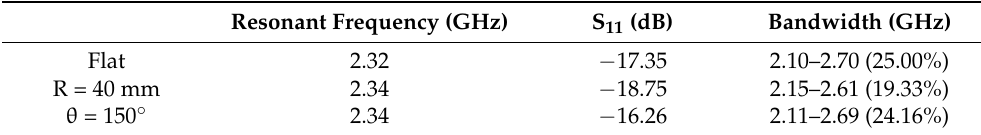
Figure 6. Simulated performance of the antenna under the flat, bending, and folding states. ( a ) Re- flection coefficients. Radiation patterns: ( b ) x – z plane; ( c ) x – y plane. Table 1. Simulated performance comparison of the antenna under the flat, bending, and folding states.